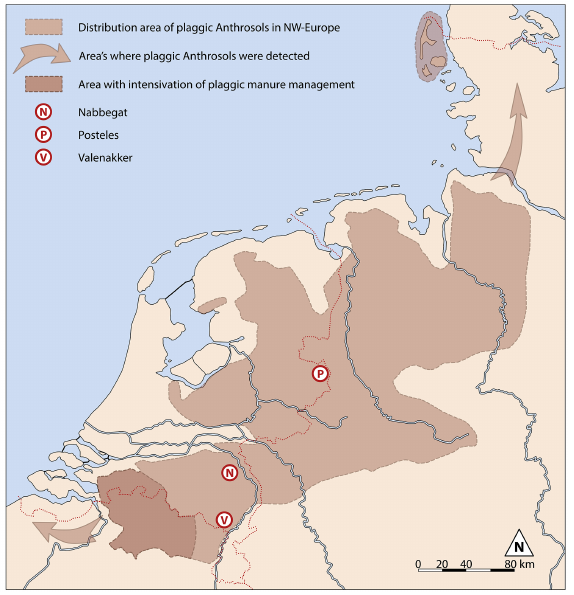
Figure 1. The location of sampled profiles Valenakker, Nabbegat and Posteles in the distribution area of plaggic agriculture.